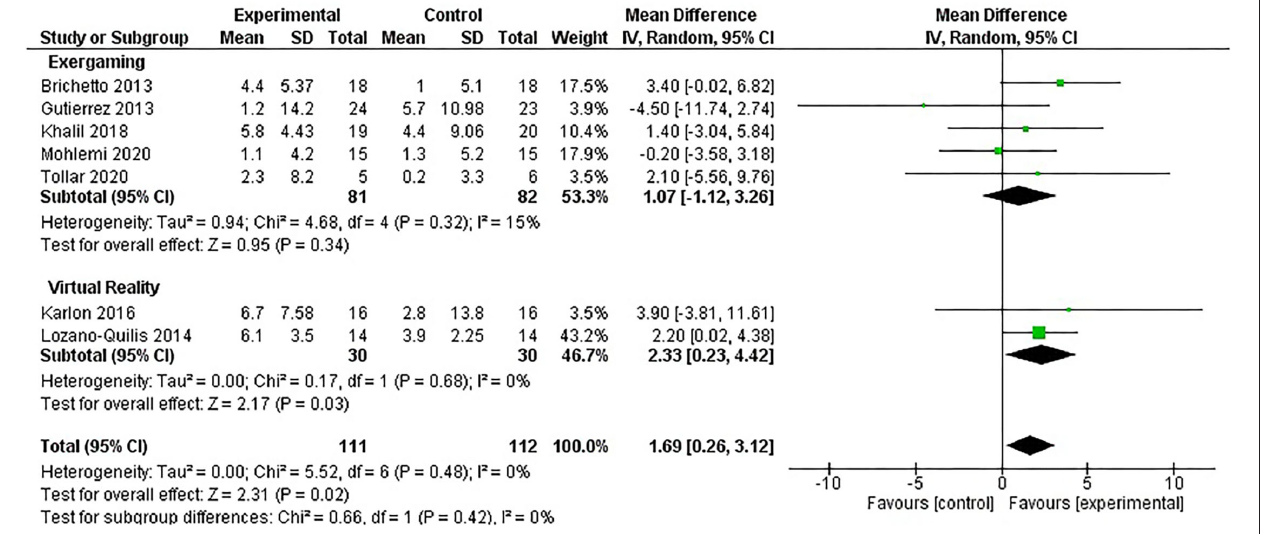
FIGURE 4 | Risk-of-bias assessed by the version 2 of the Cochrane risk-of-bias 2 (RoB 2) tool for randomized